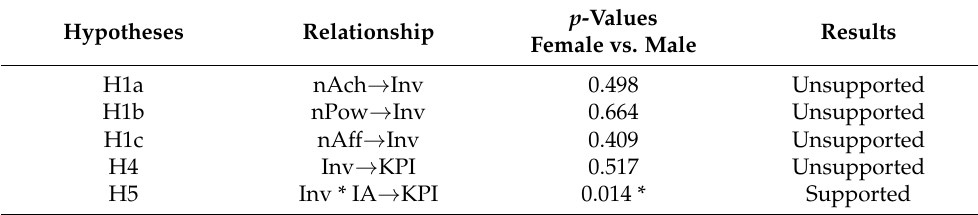
Table 10. Assessment of group difference for gender.